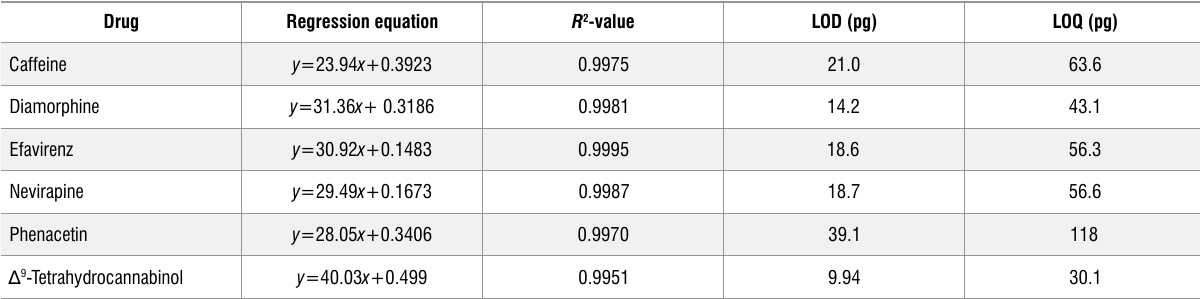
Regression equations, R 2 -values, limits of detection (LOD) and limits of quantitation (LOQ) for the exemplar drugs in nyaope Drug Regression